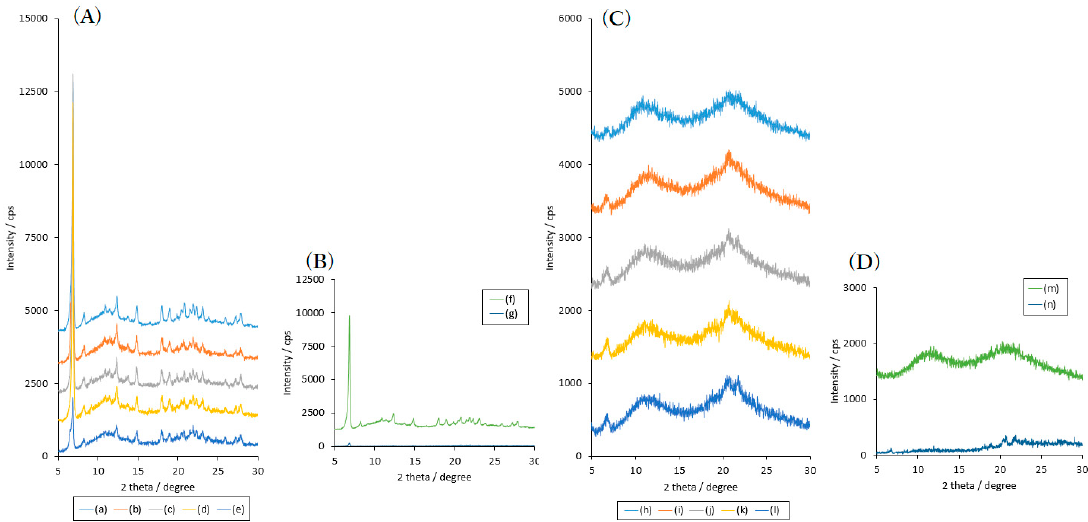
Figure 5. PXRD spectra of stored RB, SDS, and PVP mixture samples. Amorphous RB sample stored in RH 30% ( A ) and RH 75% ( B ). Bulk RB sample stored in RH 30% ( C ) and RH 75% ( D ). Storage time: 0 weeks (a, f, h, and m); 1 week (b, g, i, and n); 2 weeks (c and j); 3 weeks (c and k); 4 weeks (e and l). RH; relative humidity. RB; rebamipide. SDS; sodium dodecyl sulfate. PVP; polyvinylpyrrolidone.